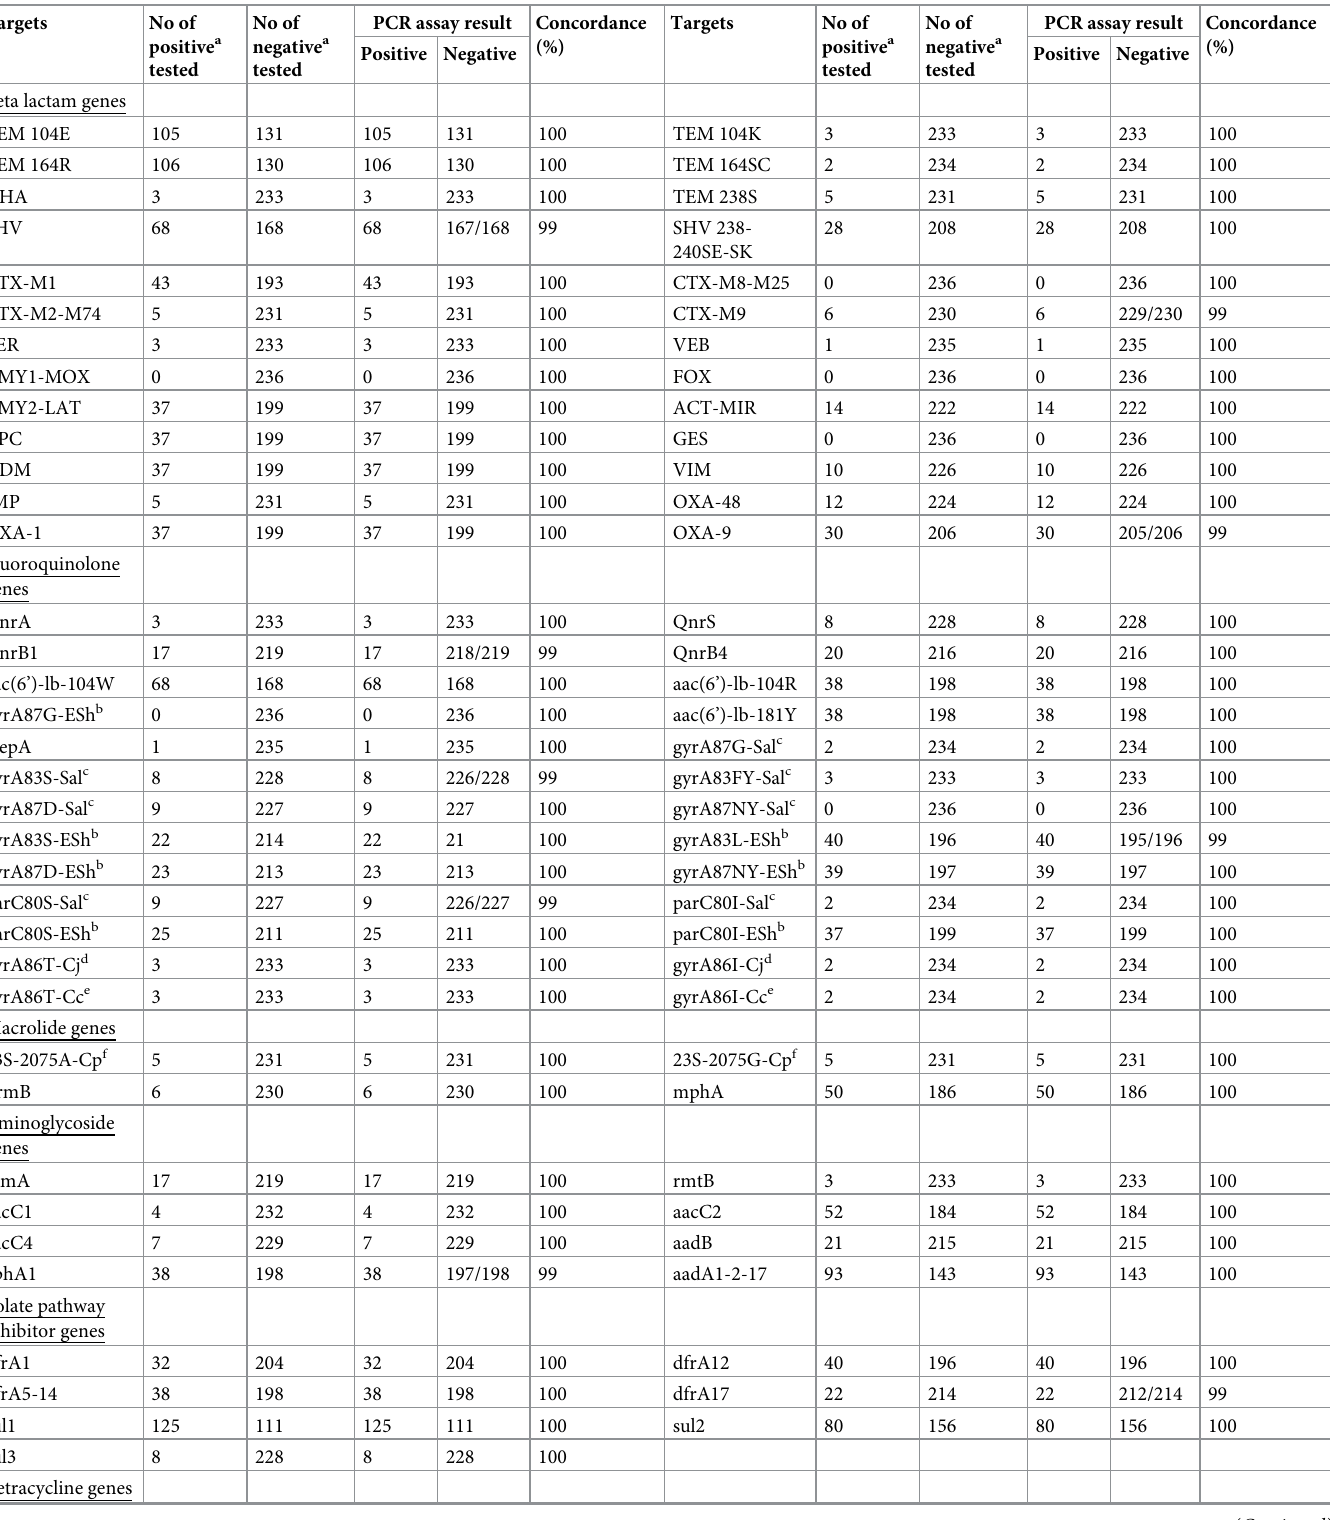
Table 1. Comparison of AMR-PCR assays versus sequencing on bacterial isolates (N = 236).